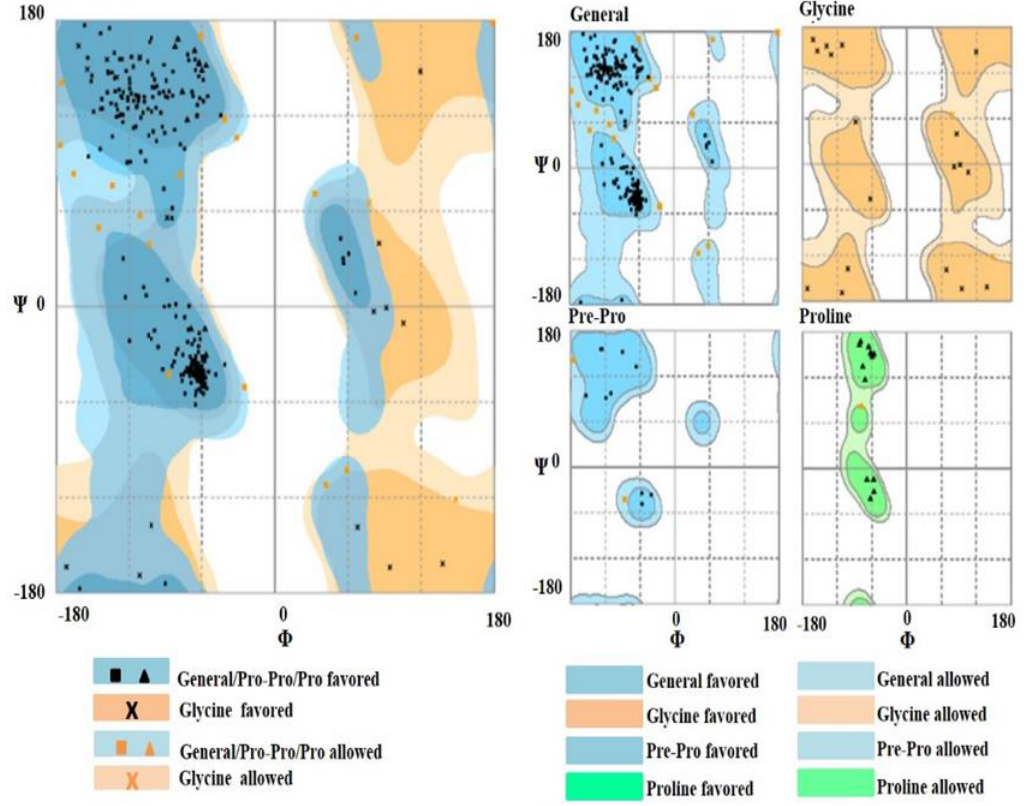
Figure 10. Stereochemical structure stability was analyzed using the Ramachandran plot analysis using RAMPAGE; 94.3% of residues fall in the favored region and 5.7% in the allowed region.